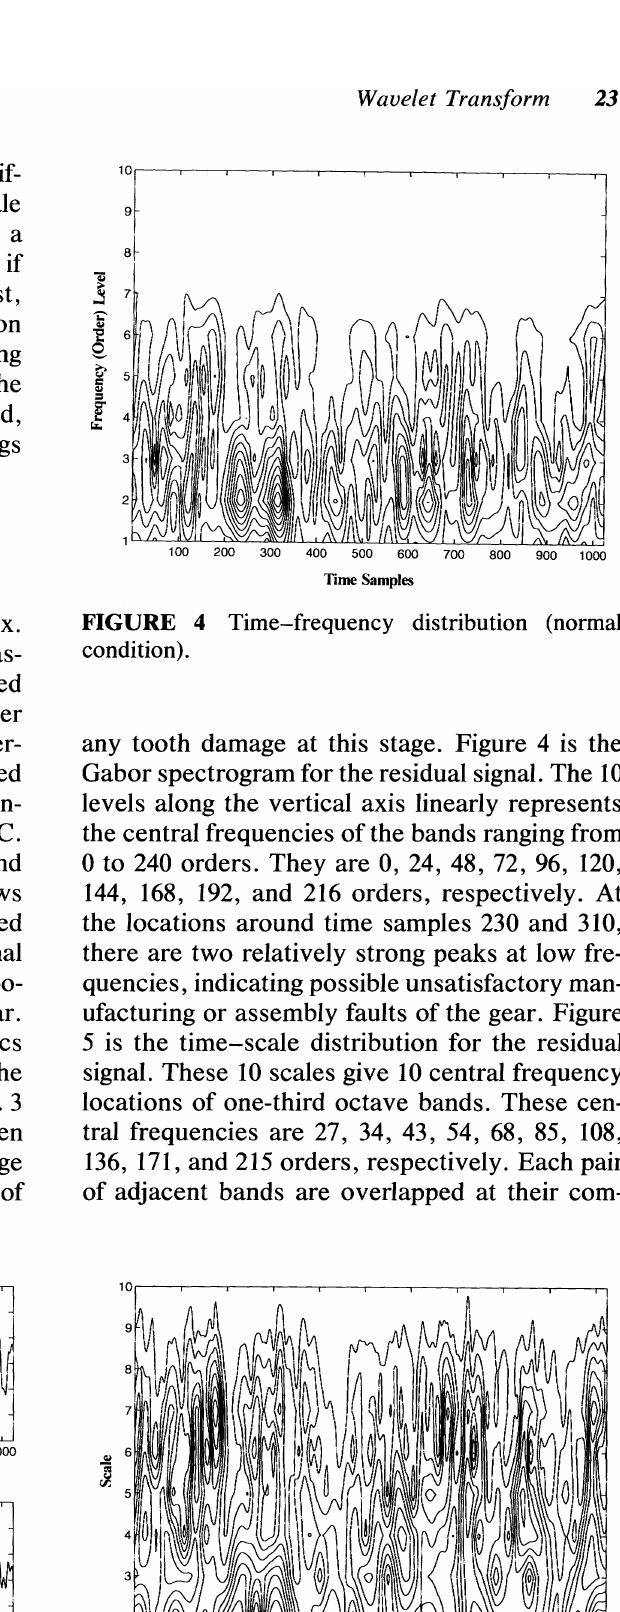
FIGURE 5 Time-scale distribution (normal condi